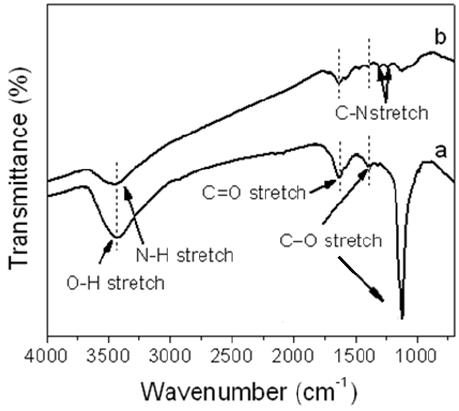
Figure 1. Fourier transform infrared (FT-IR) spectroscopy of ( a ) graphene oxide (GO) and ( b ) functionalized graphene oxide (f-GO).